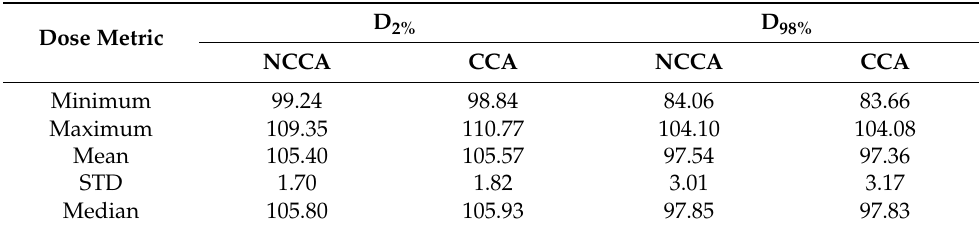
Table 6. Statistical analysis results for all brain plans revealed significant dosimetrical differences between NCCT and CCT plans, despite that these differences are within ± 1%.